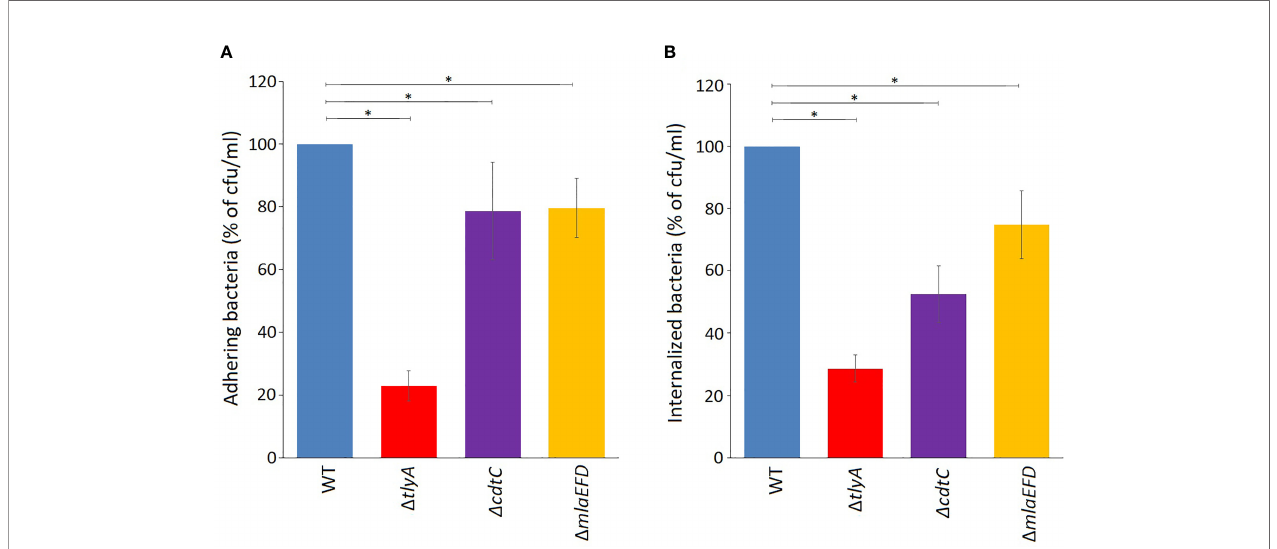
FIGURE 3 | Attenuation of virulence properties in the C. jejuni mutant strains. (A) Adhesion onto Caco-2 epithelial cells by C. jejuni was signi fi cantly reduced by the mutations; *P < 0.05 for D tlyA , D cdtC and D mlaEFD versus the wild-type (WT). (B) Invasion of C. jejuni into Caco-2 epithelial cells was also signi fi cantly reduced by each of these mutations; *P < 0.05 for D tlyA , D cdtC and D mlaEFD versus the wild-type (WT). Values represent means ± S.E.M. of three independent